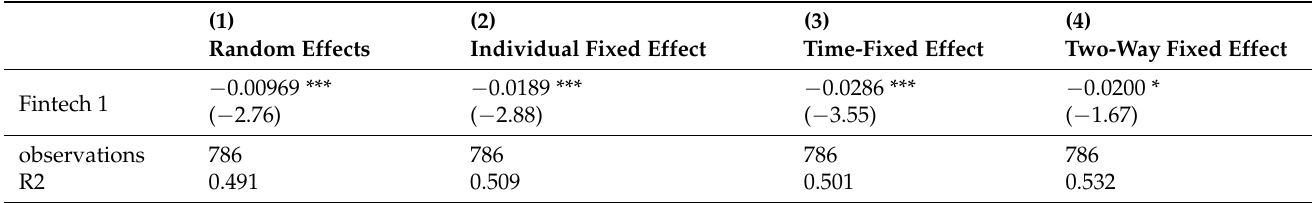
Table 8. Robustness test: remove the bank whose registered place is the